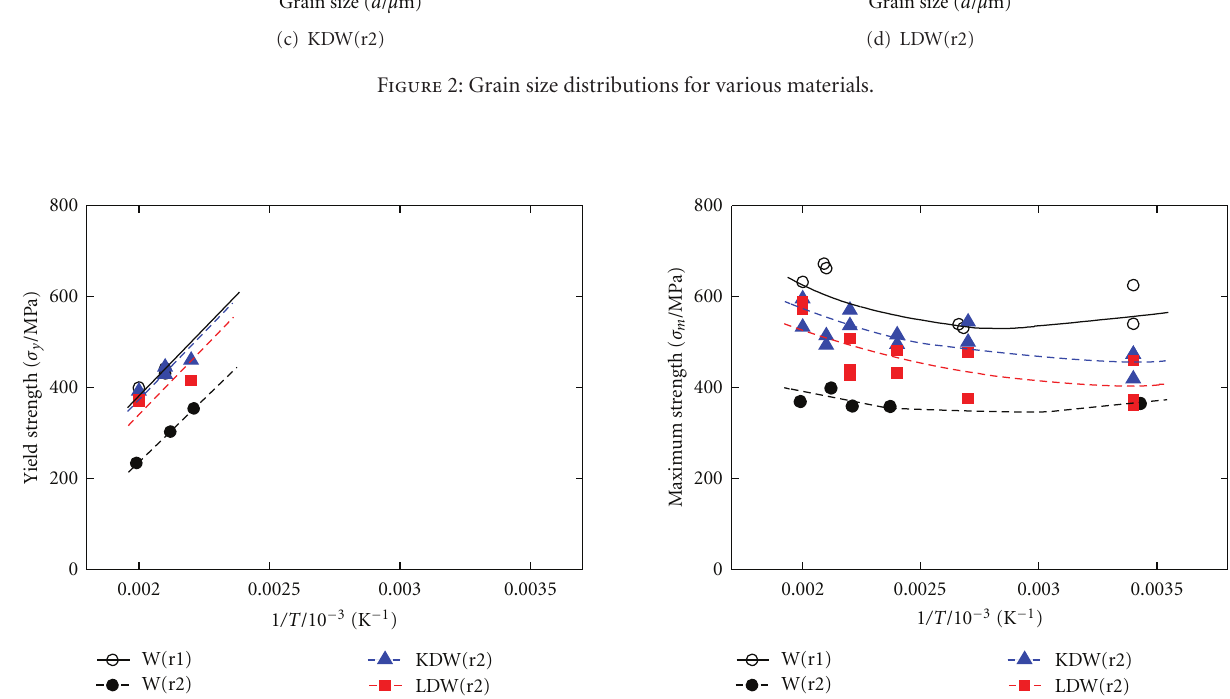
Figure 4: Plots of maximum strength against test temperature for various